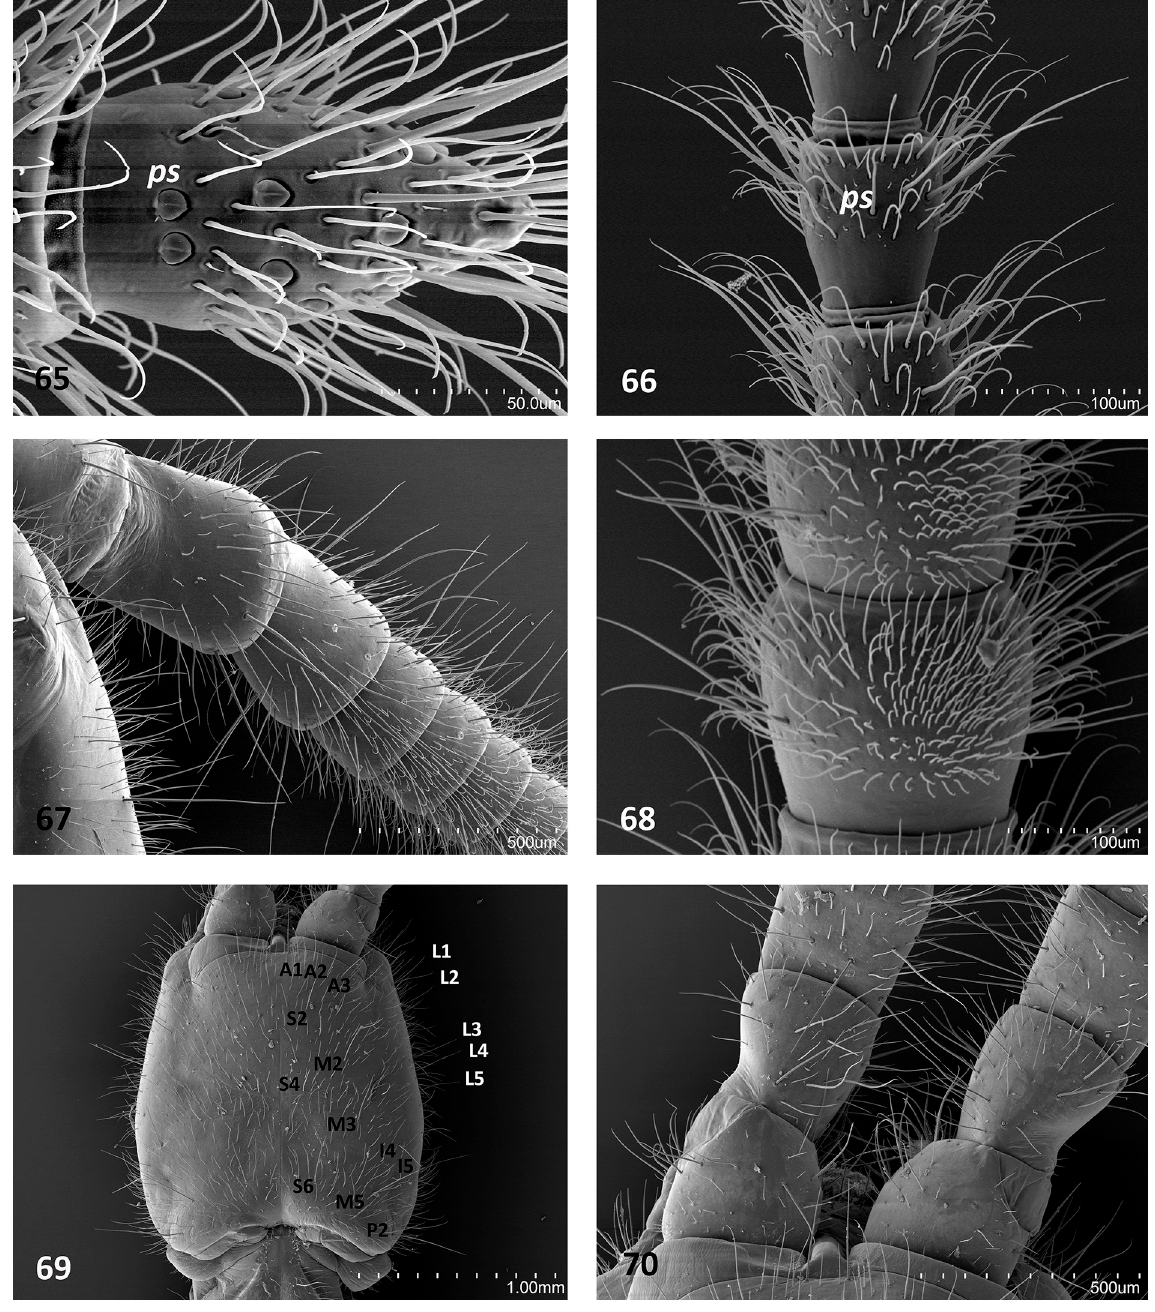
Figs 65‒70. Mueggejapyx brehieri Sendra & Komerički gen. et sp. nov. 65 . Last antennomere with placoide sensilla ( ps ). 66 . Distal antennomeres with placoide sensilla ( ps ). 67 . Central antennomeres. 68 . Proximal antennomeres, ventral side. 69 . Head, dorsal side. Abbreviations: see Material and methods. 70 . Proximal antennomeres, dorsal